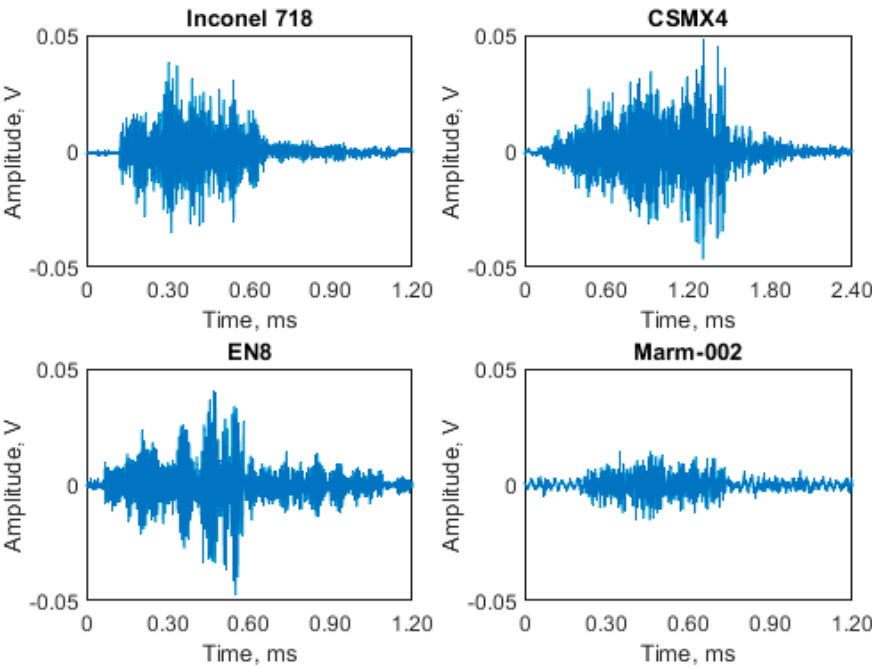
Figure 20. AE SG events for Inconel 718, CSMX-4, EN8 & MARM-002.